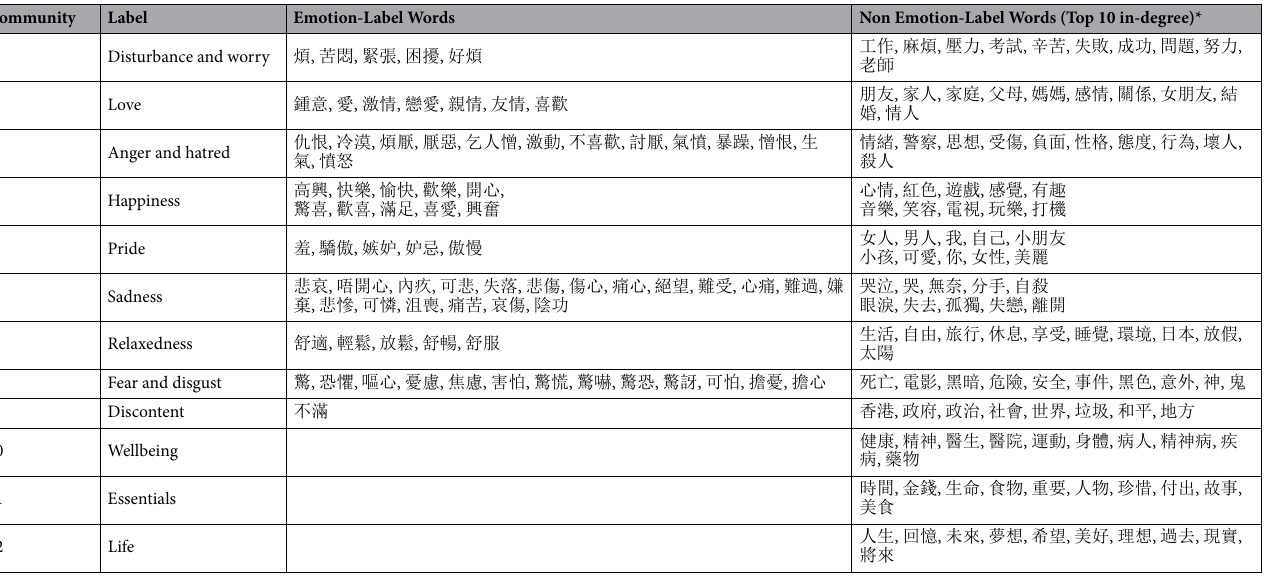
Table 2. Communities in the G emotion . *Please refer to Table S5 in supplementary material for the Cantonese pinyin and